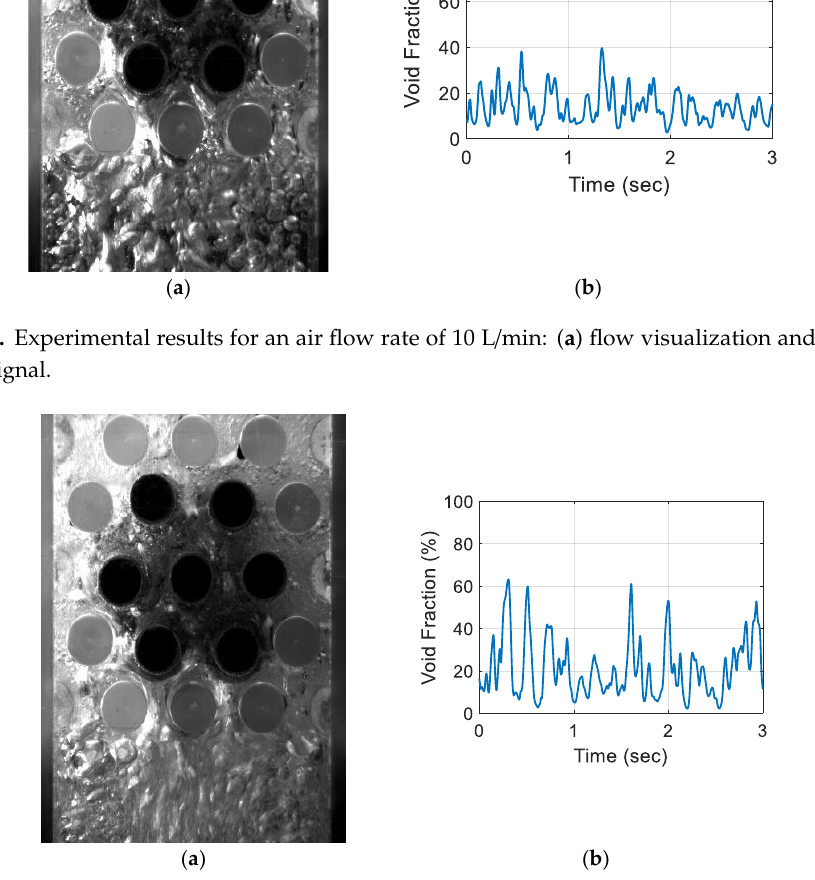
Table 2. Average void fraction data for different air flow rates using the single-sensor configuration.